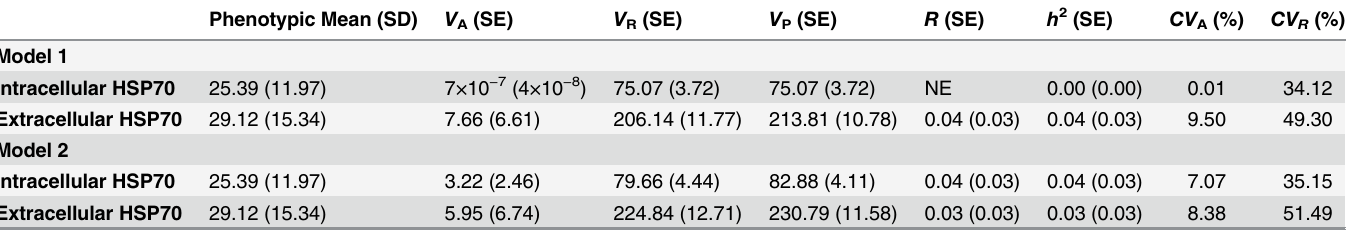
Genetic estimates of the additive genetic variance ( V A ); residual variance ( V R ); phenotypic variance ( V P ); heritability ( h 2 ); and coef fi cients of